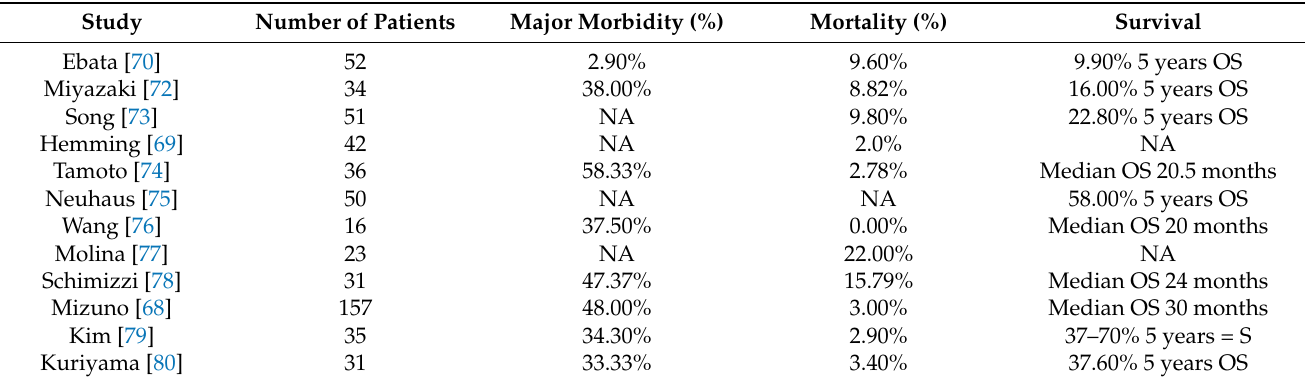
Table 3. Major studies on portal vein resection for